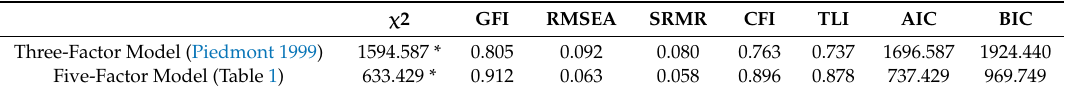
Table 2. Fit Indices from Confirmatory Factor Analyses.